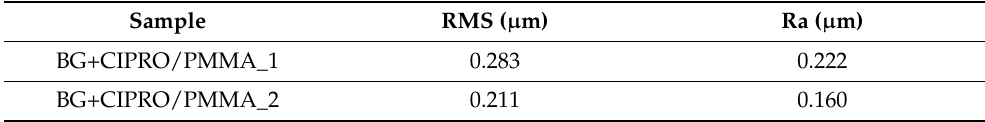
Table 1. Roughness values of thin films before immersion in SBF.